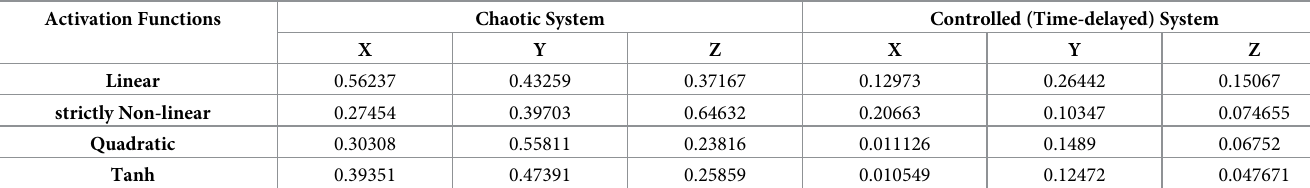
Table 4. Mean square error (MSE) for chaotic and controlled system in Experiment set